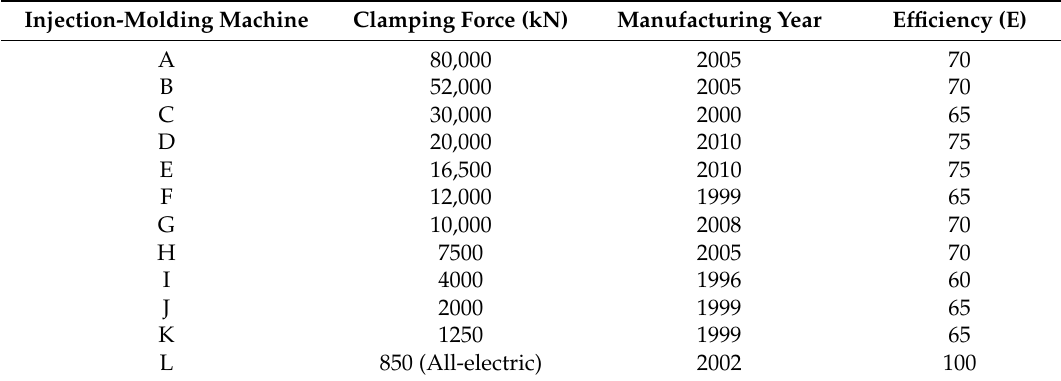
Table 2. Machine efficiency values for the empirical model,